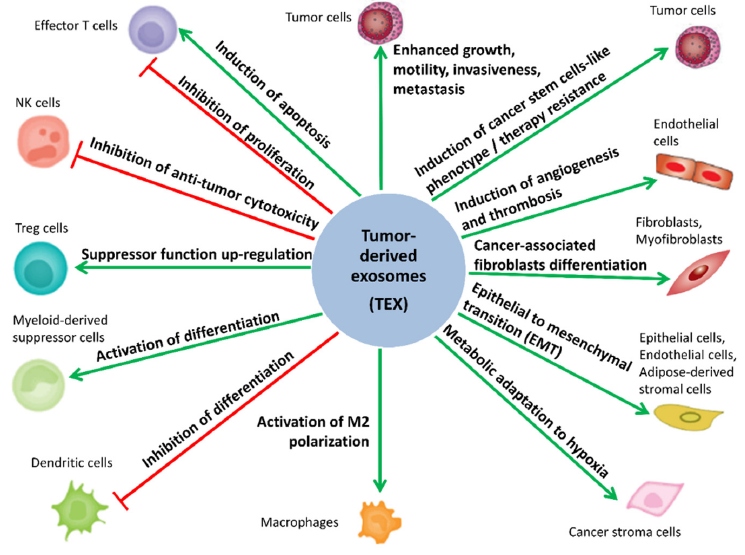
Figure 1. Role of tumor-derived small extracellular vesicles (sEV) (TEX) in cancer biology. Tumor-derived exosomes (TEX) are involved in intercellular signaling and communication between tumor cells and non-malignant cells residing in the tumor microenvironment. TEX reprogram these cells to acquire functions favoring tumor growth and metastasis. TEX-induced changes include enhancing cancer immune escape, remodeling of the tumor stroma, molecular and metabolic reprogramming, and promotion of angiogenesis. Green arrows indicate the processes stimulated by TEX. Red lines with blunt ends indicate processes inhibited by TEX.